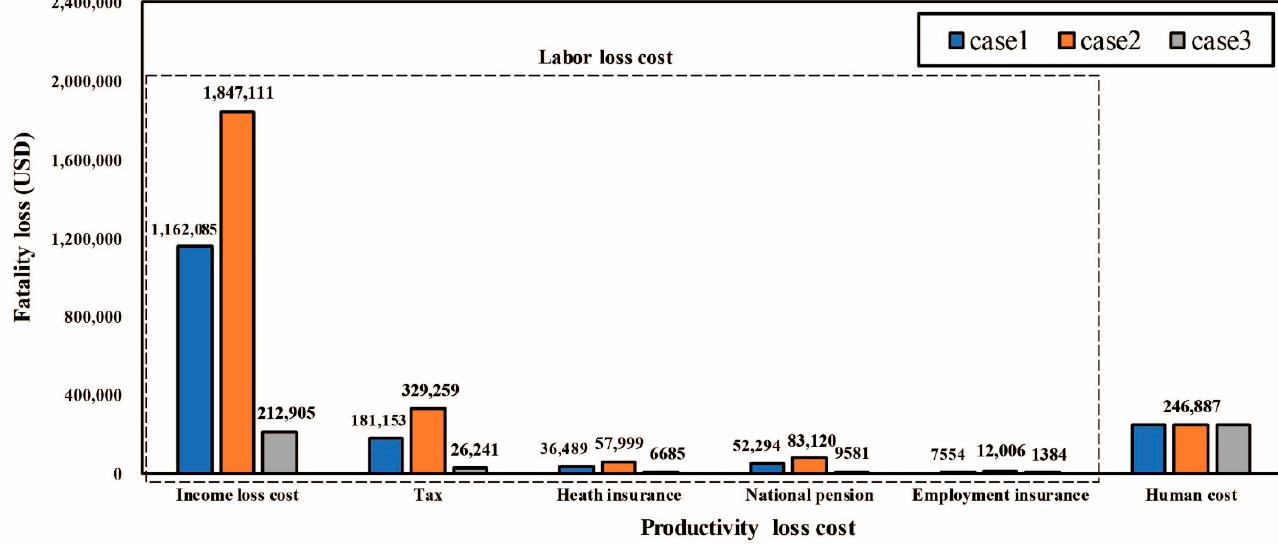
Figure 4. Comparison of productivity loss cost.